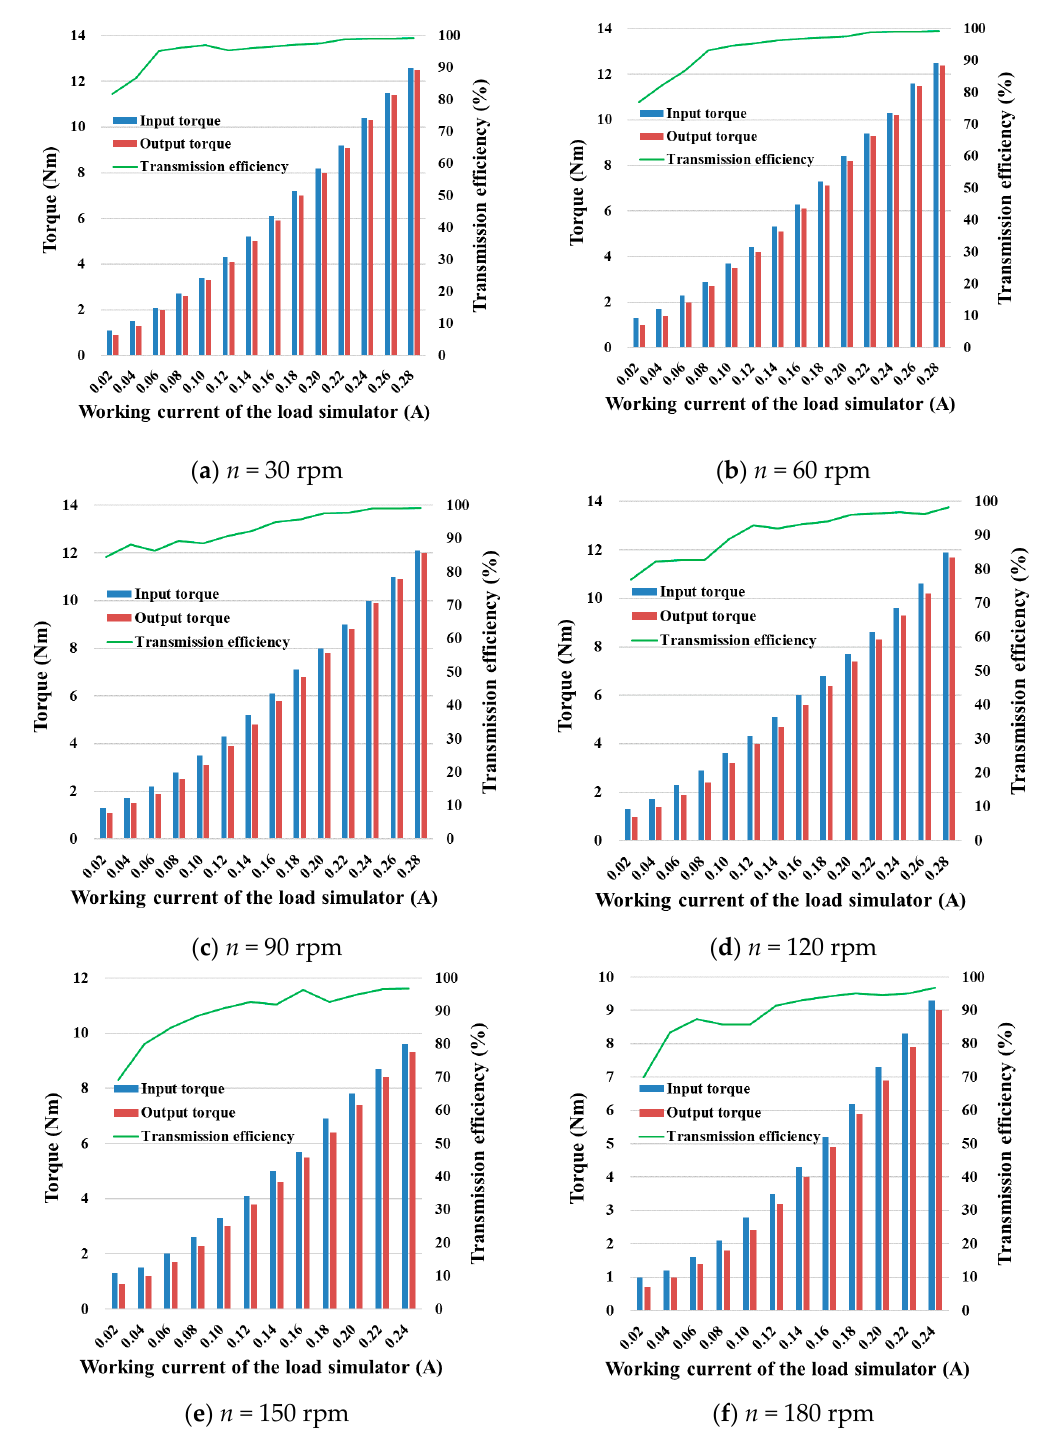
Figure 17. The dynamic performance of the magnetic coupling.